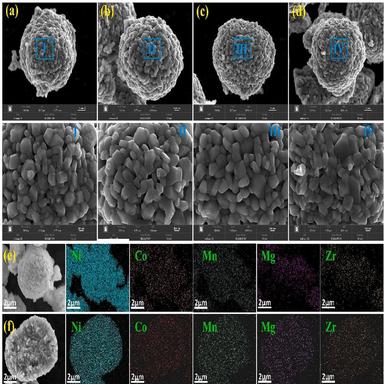
SEM images of (a) bare NCM, (b) M3-NCM, (c) Z2-NCM and (d) MZ-NCM; (e) Surface and (f) cross-sectional EDS elemental mapping of MZ-NCM.